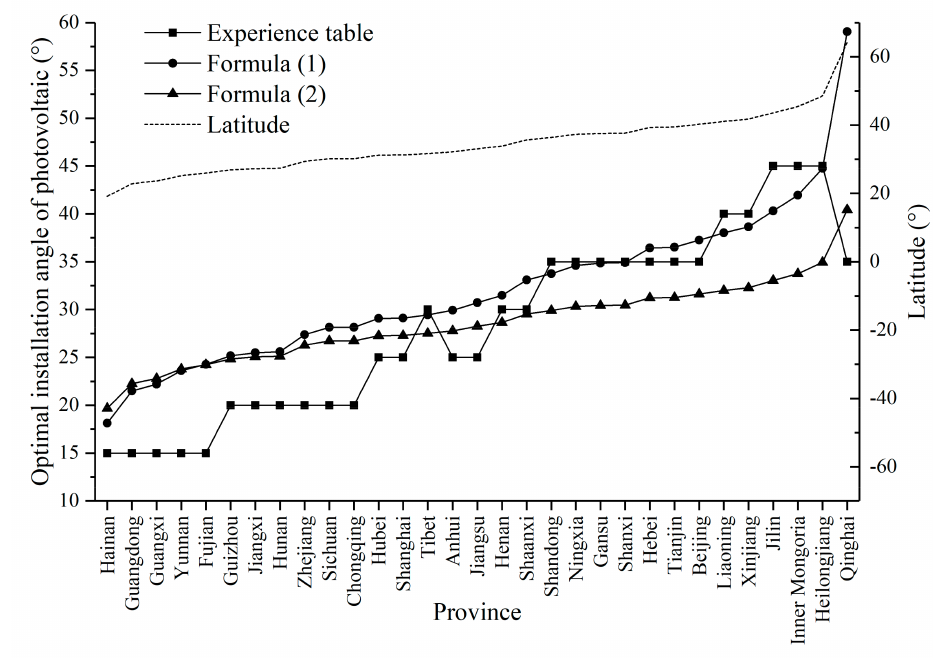
Figure 6. Comparison of the best installation angle of cities in different provinces.